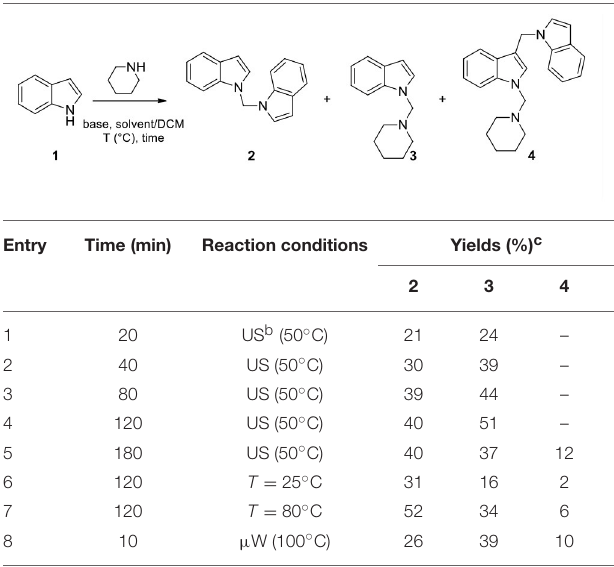
TABLE 1 | Reaction of indole with piperidine using different approaches a